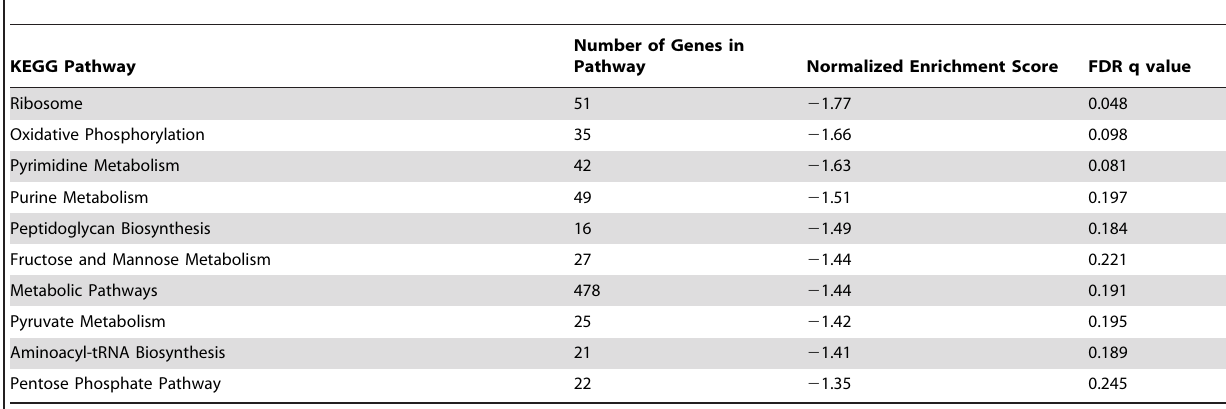
Table 2. KEGG Canonical Pathways that are Enriched with Genes Downregulated in B. theta from Monoassociated HLA-B27 Tg Rats.